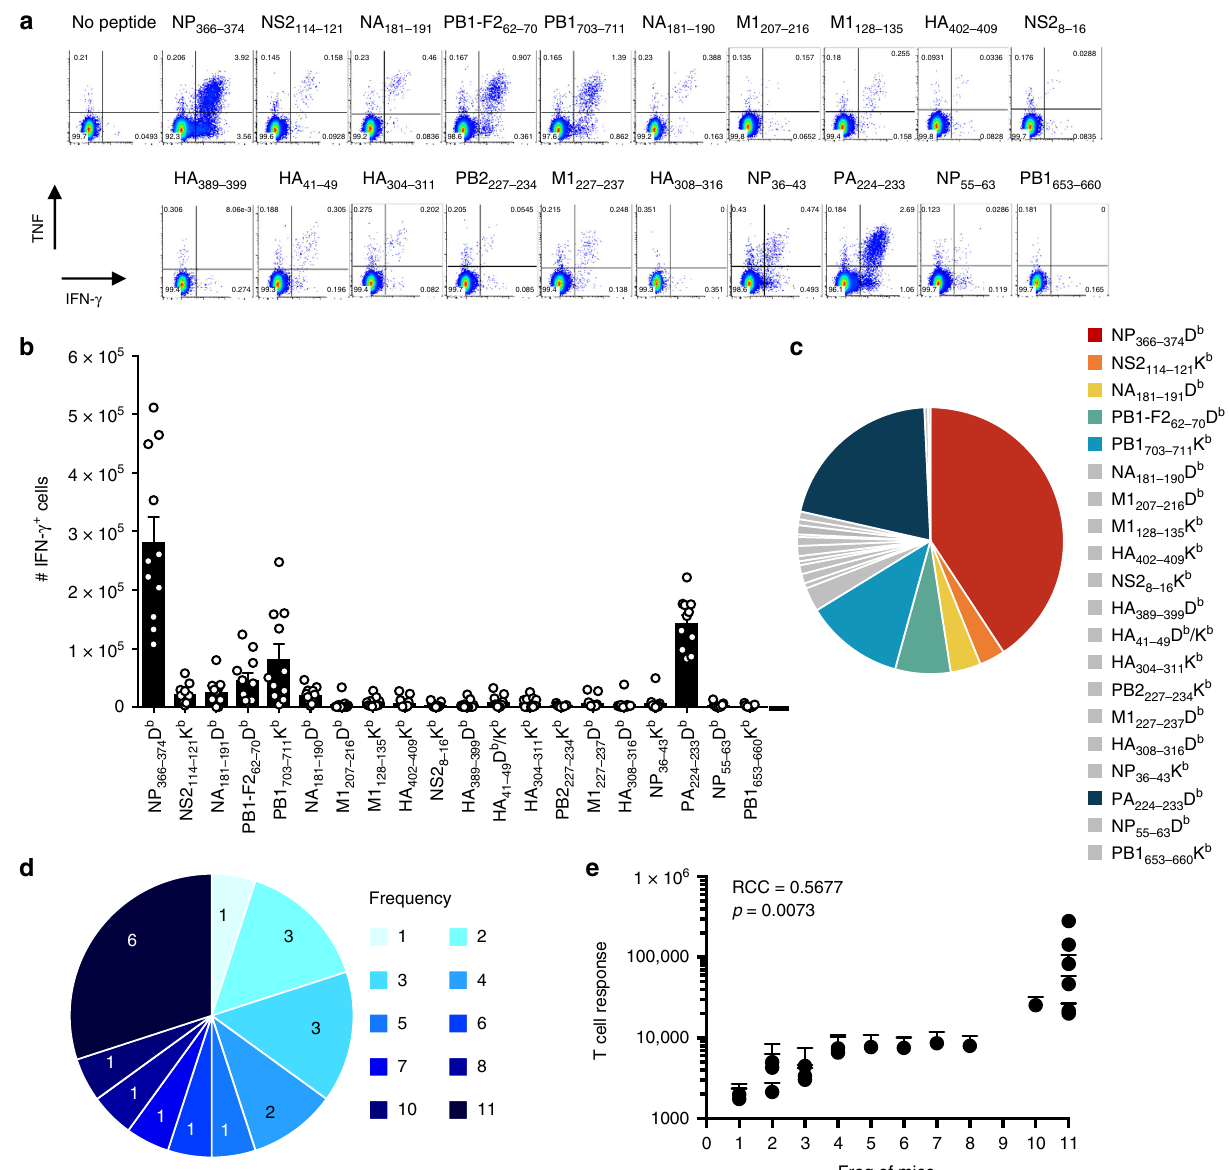
Fig. 5 Analysis of primary CD8 + T-cell responses to IAV-derived peptides. Naive B6 mice were infected i.n. with 1000 pfu PR8 IAV, and spleens harvested 10 days later. Splenocytes, enriched for CD8 + T cells, were stimulated for 5 h in the presence or absence of 1 μ M of individual peptides, and analyzed by intracellular staining for the production of IFN- γ and TNF. a Representative dot plots of CD8 + T-cell production of IFN- γ and TNF following peptide re- stimulation. Values indicate the percentage of CD8 + cells within each gate. b Number of splenic CD8 + IFN- γ + cells responding to each peptide from 11 mice in two independent experiments ± SEM. c Relative contribution of each detectable epitope-speci fi c CD8 + T-cell response to the total detectable response. d Frequency (out of a total of 11 mice) with which the identi fi ed peptides are able to elicit CD8 + T-cell responses. Numbers within pie chart indicate number of peptides. e The mean + SEM CD8 + T-cell response plotted against the cumulative number of mice in which the responses were detected. N = 11 mice from two independent experiments. Source data are provided as a Source Data